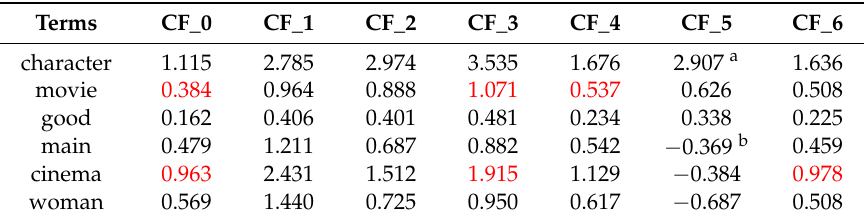
Table 4. Fragment of the Reduced Model.